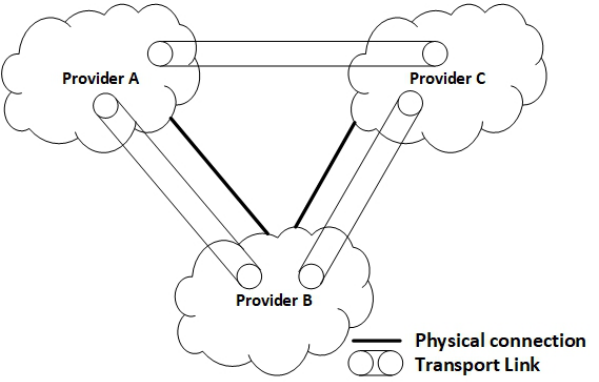
Figure 8. A full mesh of Transport Link